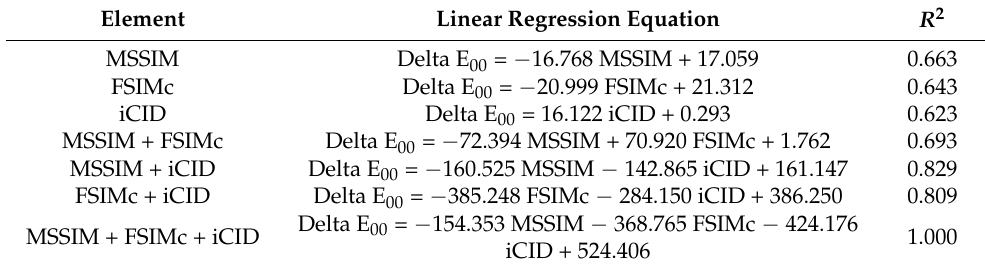
Table 10. Linear regression equation using the CIEDE2000 color difference